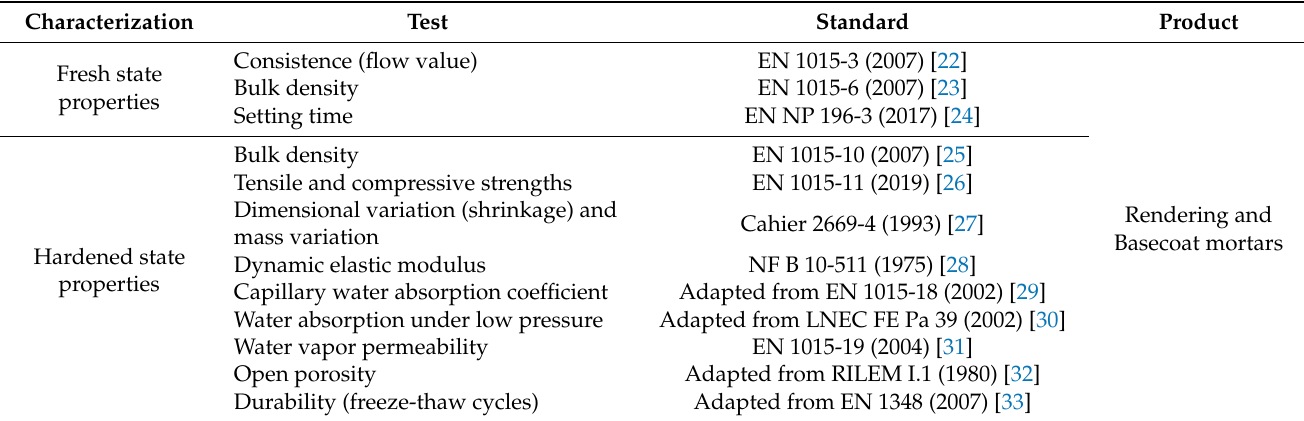
Table 4. Tests performed in experimental